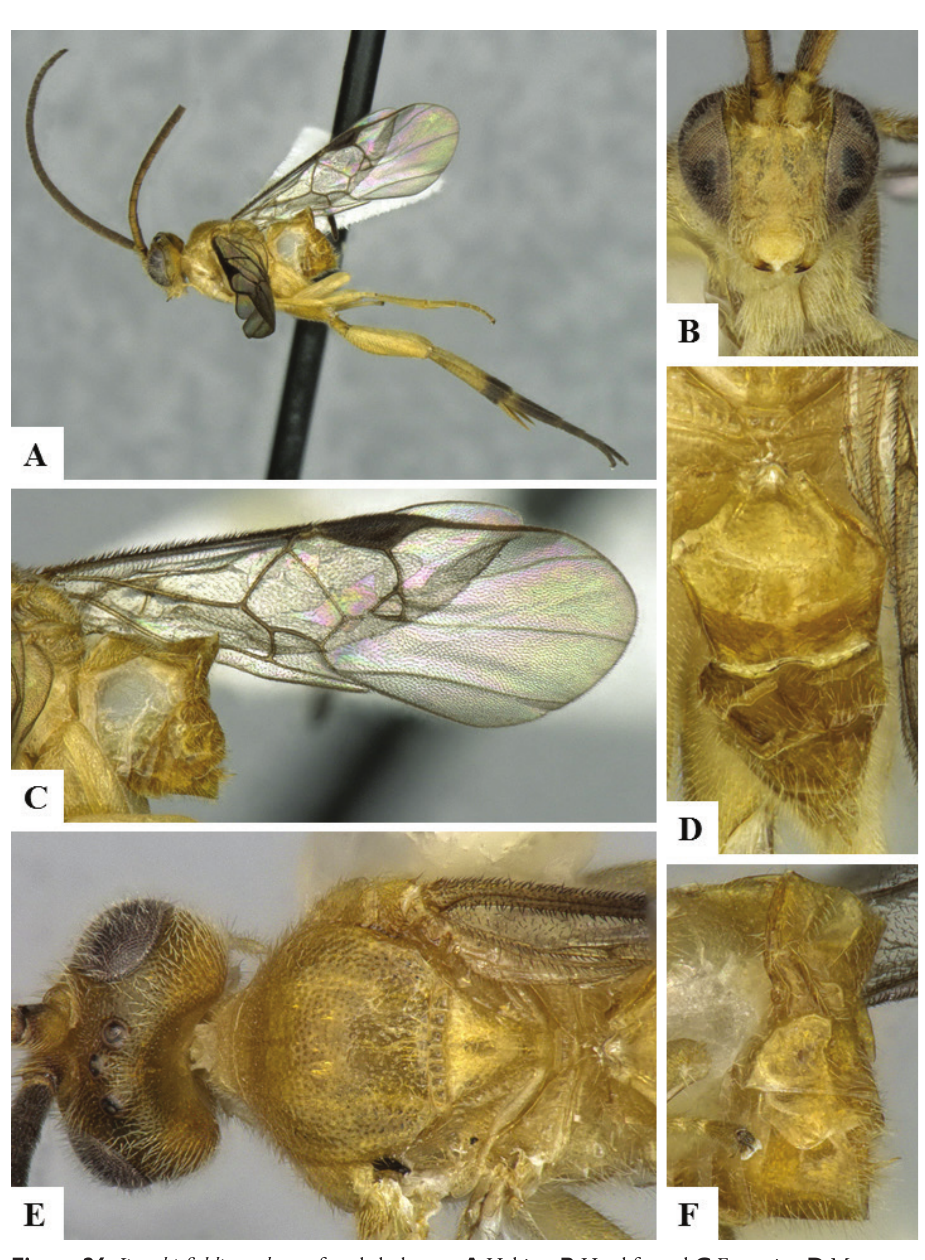
Figure 26. Jimwhitfieldius sydneyae female holotype. A Habitus B Head frontal C Fore wing D Metasoma dorsal E Head and mesosoma, dorsal F Hypopygium and ovipositor, lateral. 16.521000, 99.658000, 1306m, 2.iv.2008, coll. C. Piluek, Voucher code: JMIC0026; (1 ♂ CNC), Phetchabun, Nam Nao NP, Check Point, 16.437000, 101.638000,